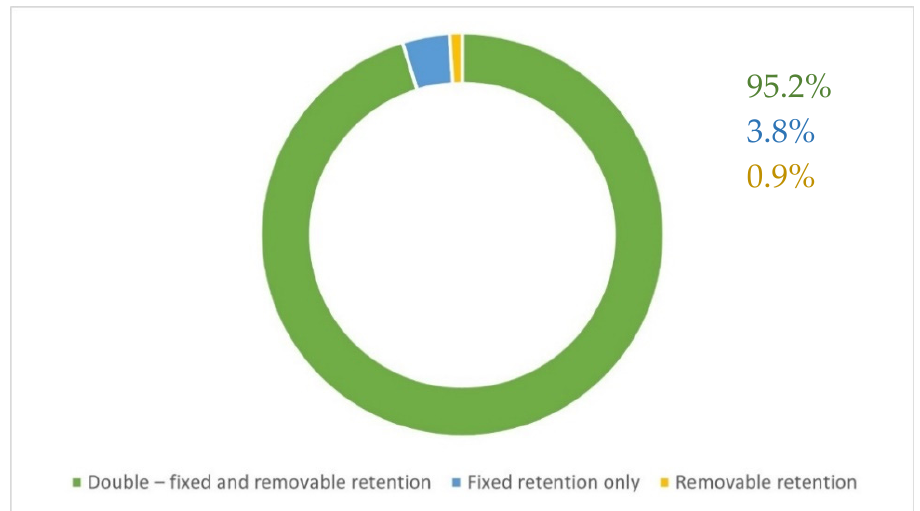
Figure 2. Distribution of the retention types used.